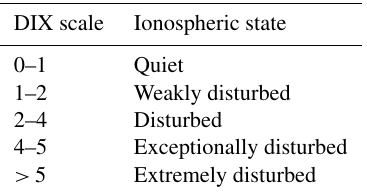
Table 1. The ionospheric states according to the DIX scale.